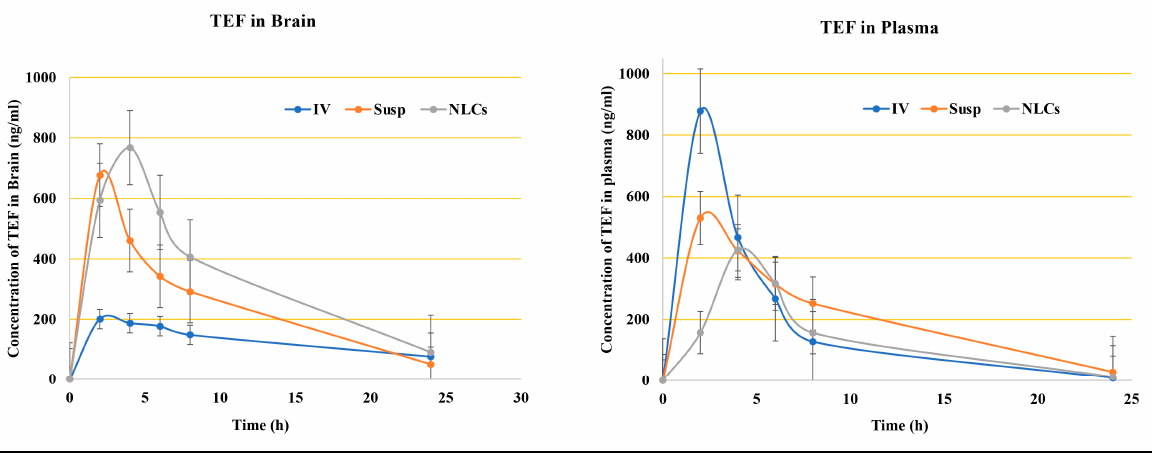
Figure 5. The brain and plasma drug profiles after intravenous (IV) and intranasal (IN) administration of both NLCs and free TEF suspension. The study was performed in triplicate data that are shown in mean ± SD ( n = 3); the statistical analysis was performed between each group and the di ff erences were considered signi fi cant ( p < 0.005). The IN administration of NLC system was highly signi fi cant ( p < 0.002) to TEF free suspension group.